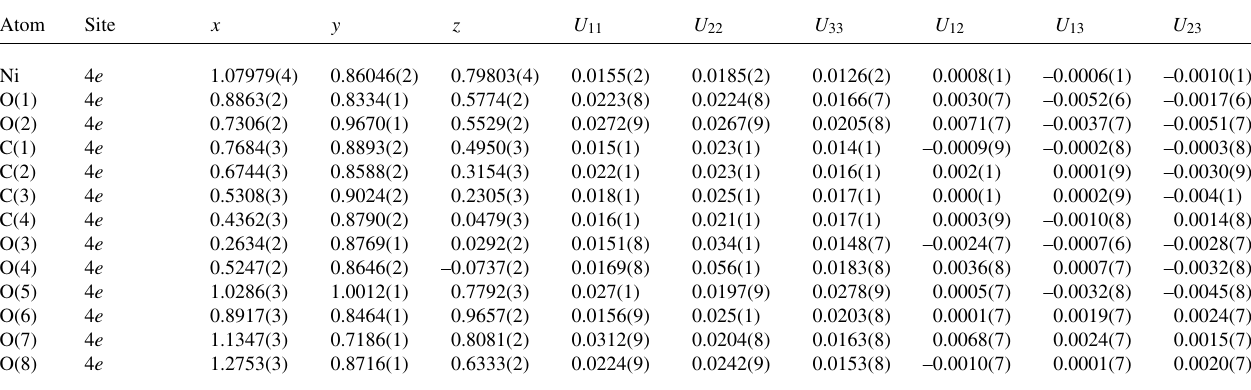
Table 3. Atomic coordinates and displacement parameters (in Å 2 )